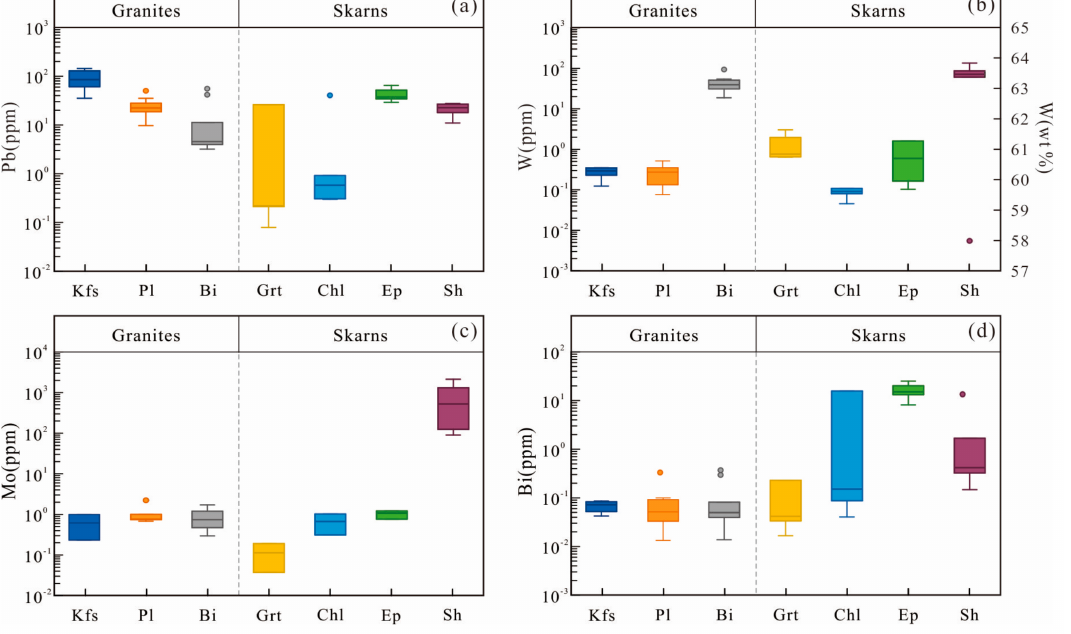
Figure 5. Box plots of ( a ) Pb, ( b ) W, ( c ) Mo and ( d ) Bi concentrations of main silicate minerals